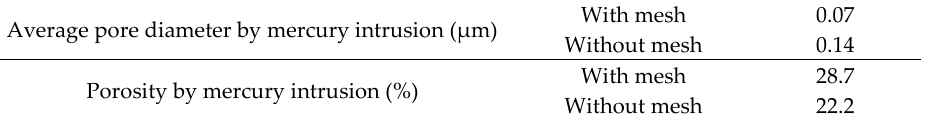
Figure 13. Porosimetry properties obtained by mercury intrusion of air lime mortar applied to solid ceramic brick substrate, with and without mesh. Table 13. Air lime mortar applied to the natural stone substrate.